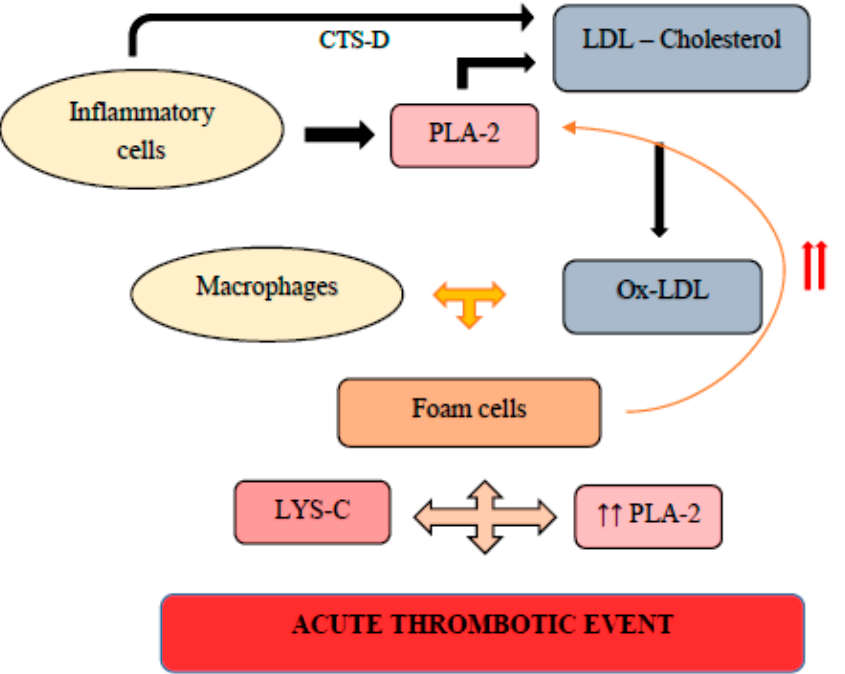
Figure 3. Inflammatory proteins involved in atherosclerotic plaque instability detected in tissue samples. CTS-D, Cathepsin-D; LYS-C, Lysozyme-C; ox-LDL, oxidized-LDL; PLA-2, Phospholipase- ples. CTS-D, Cathepsin-D; LYS-C, Lysozyme-C; ox-LDL, oxidized-LDL; PLA-2,